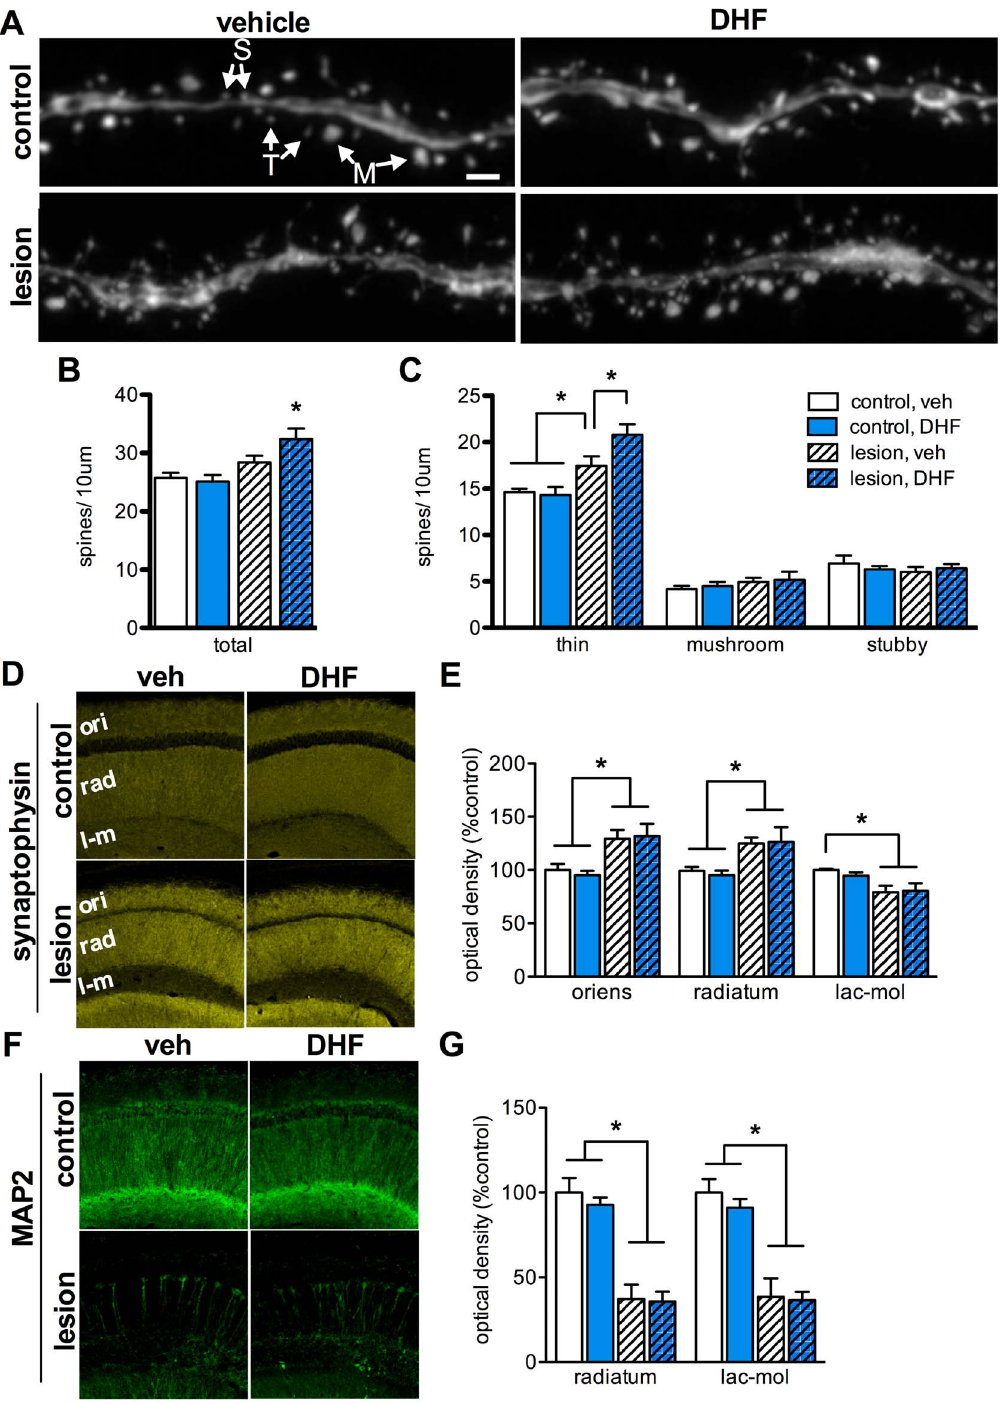
Figure 3. 7,8-DHF treatment increases thin spine density on dendrites in CA1 pyramidal neurons. High-magnification confocal imaging and analysis of dendrites from GFP-expressing CA1 pyramidal neurons reveals elevated total spine density in 7,8-DHF-treated lesioned mice ( A–B , n =5–7, p , 0.05). Classification of thin (T), mushroom (M), and stubby (S) spines indicates a specific elevation of thin spines in lesioned mice ( C , n =5– 7, p , 0.05), which is further elevated by 7,8-DHF treatment ( n =5–7, p , 0.01 versus vehicle-treated lesioned mice). Analysis of synaptophysin immunoreactivity reveals a lesion-induced increase in presynaptic terminal packing density in CA1 stratum oriens (ori) and radiatum (rad) ( D–E , n =5, p , 0.05), and loss of density in the stratum lacunosum-moleculare ( D–E , n =5, p , 0.01), but no effect of 7,8-DHF. Labeling for MAP2 reveals a significant loss of CA1 pyramidal neuron dendrites in lesioned groups ( F–G , n =5–7, p , 0.001), and no impact of 7,8-DHF treatment on dendrite density. Scale bar=1 m m.